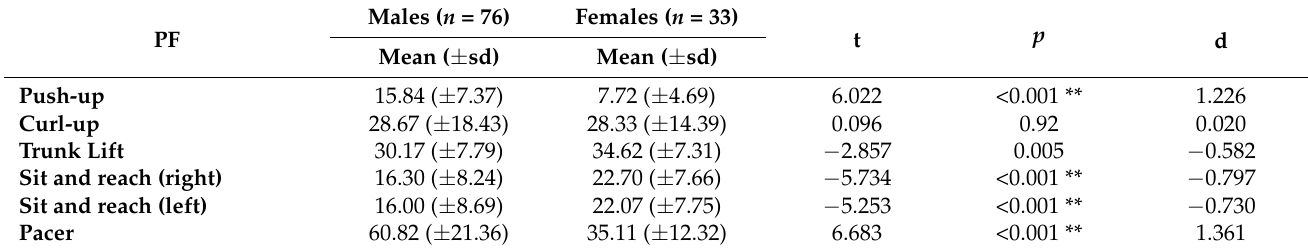
Table 5. Mean, standard deviation, and PF comparisons between sex.